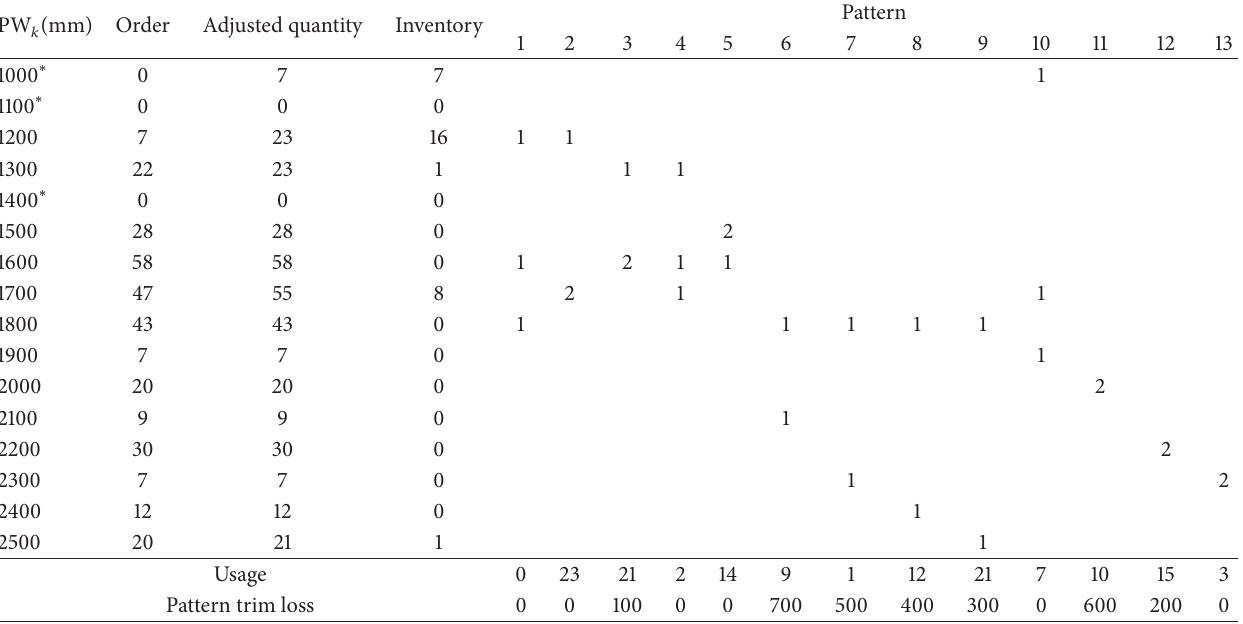
Table 8: The results of a manual fine-tuning